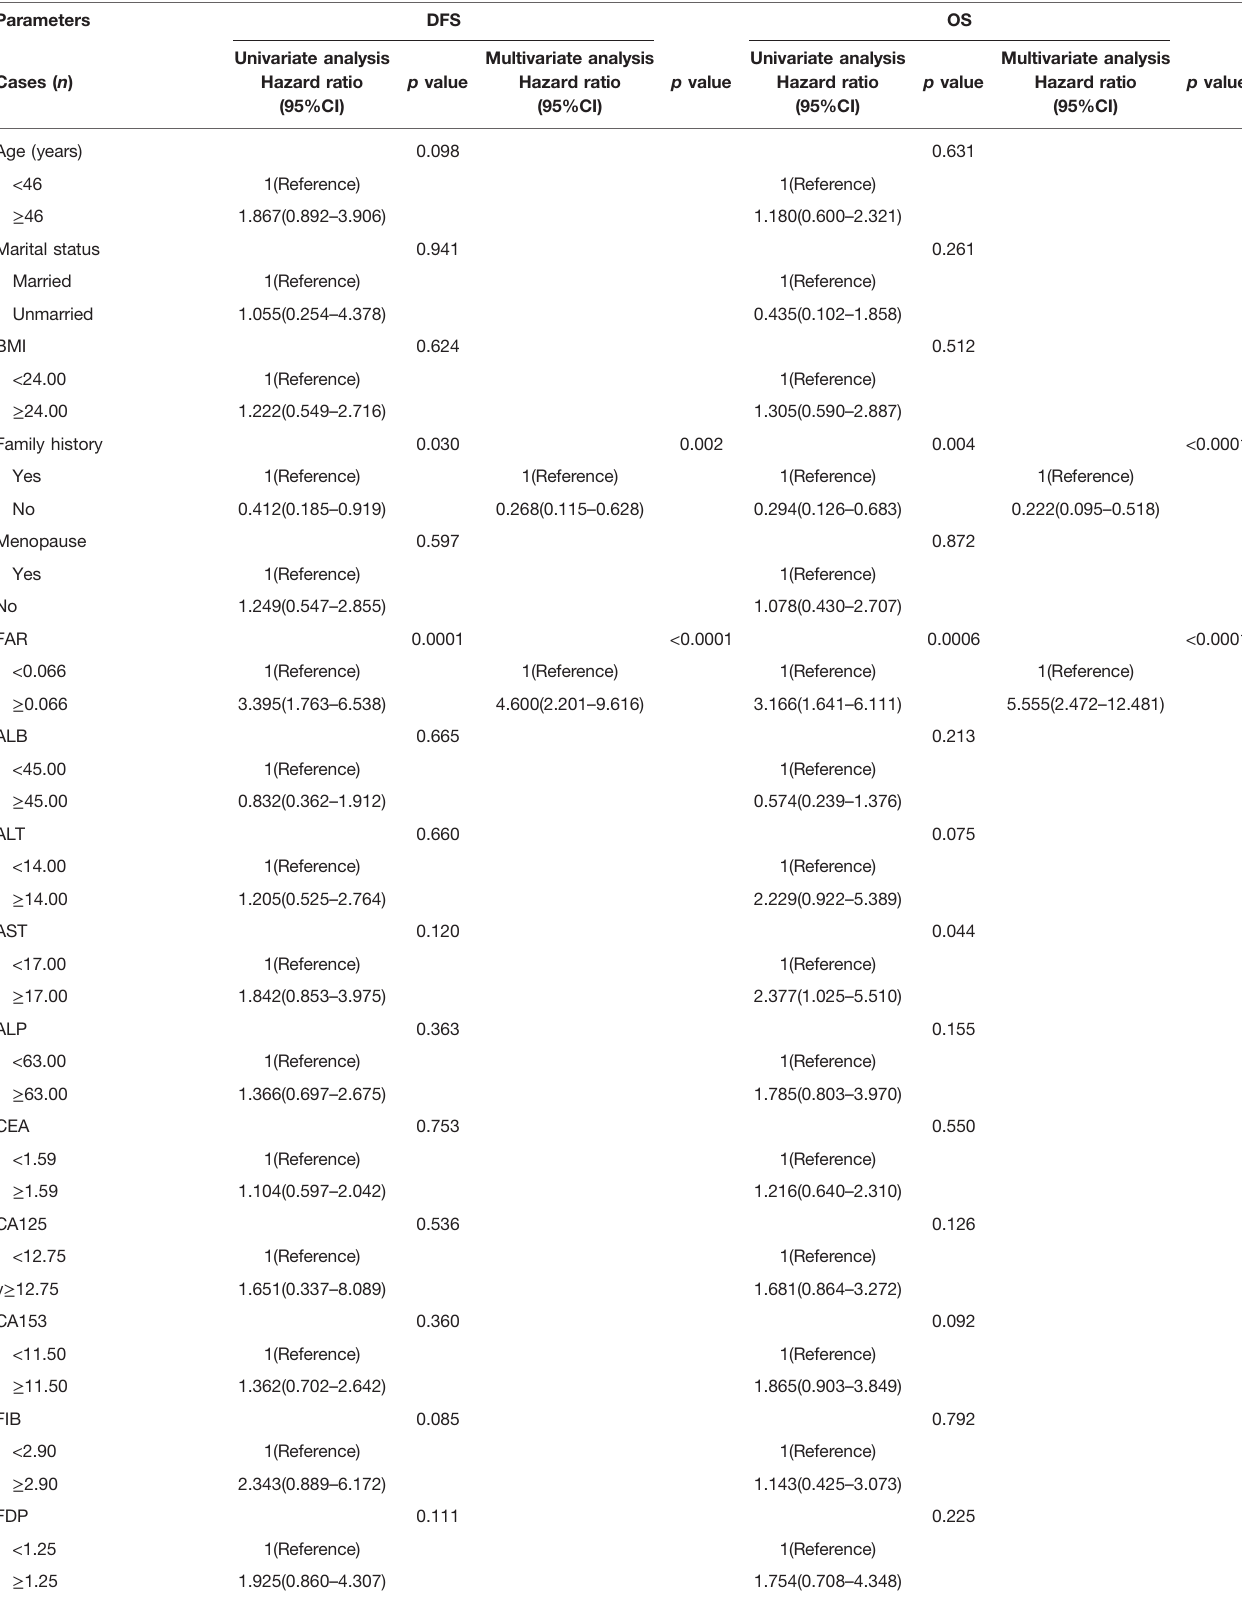
TABLE 4 | Univariate and multivariate Cox regression survival analyses of the FAR for the prediction of DFS and OS in triple-negative breast